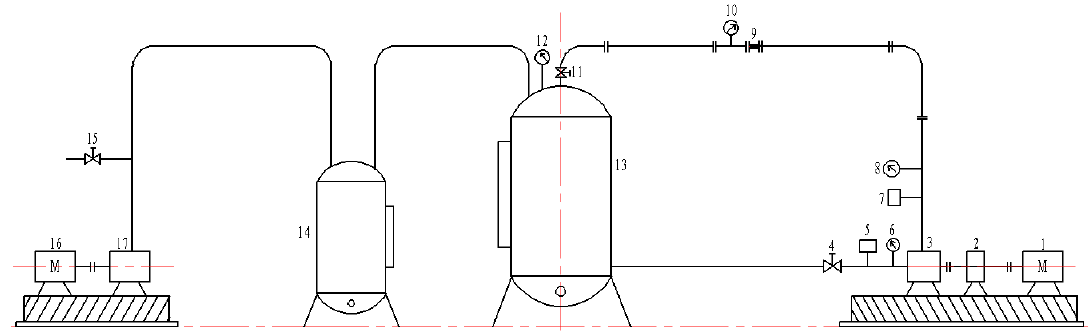
Figure 24. Components of the closed performance experiment rig. 1–electric motor; 2–torque and